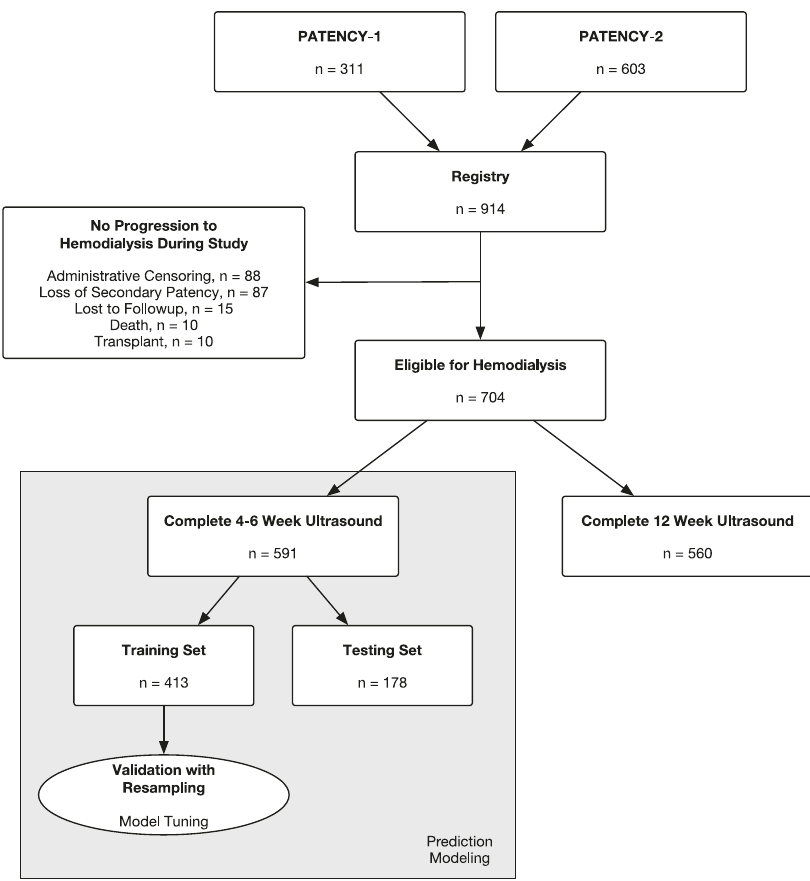
Fig. 1 Cohort selection fl owchart. Depicts fl ow from PATENCY-1 and PATENCY-2 randomized trials into prospective registry, eligibility for hemodialysis, receipt of postoperative ultrasound, and ultimate entry into predictive modeling